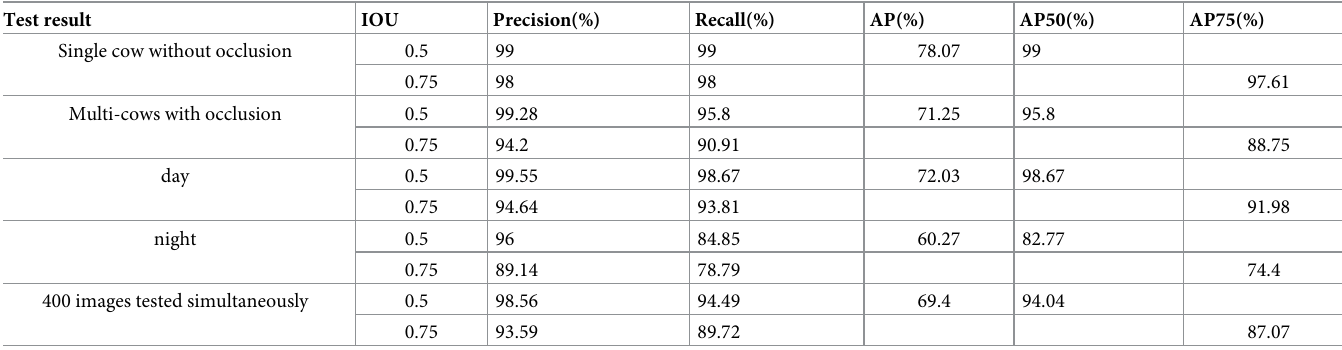
Table 1. Evaluation indicators of object detection under different